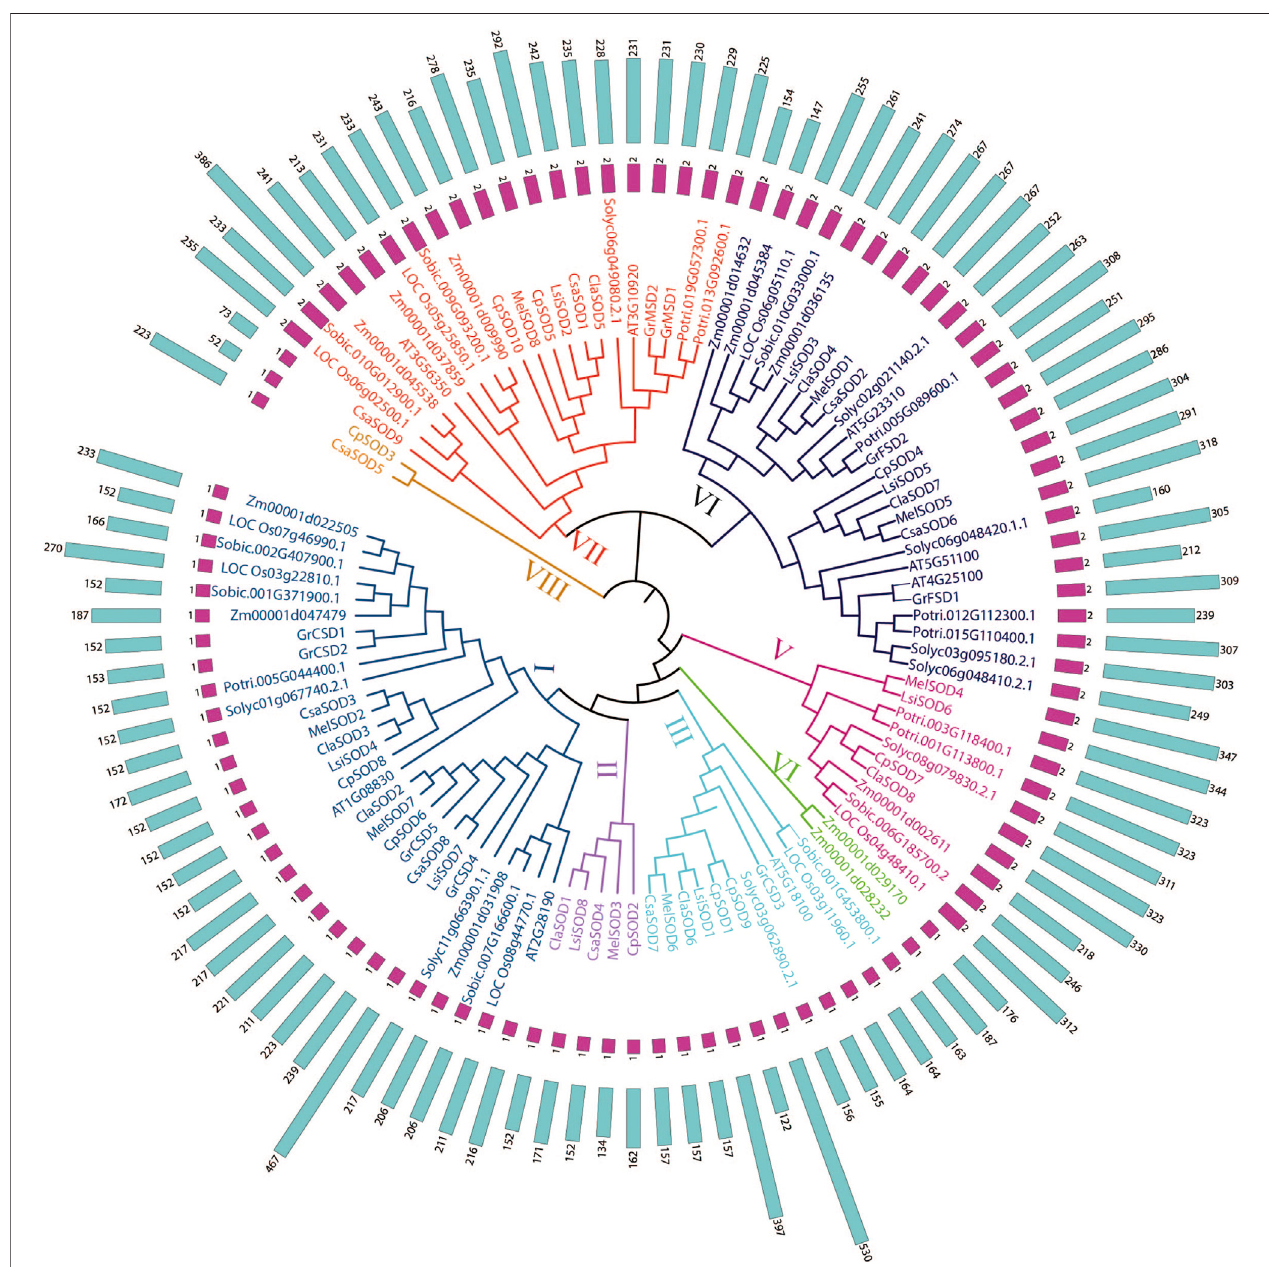
FIGURE1| Phylogenetic treeof106SODproteins from Lagenariasiceraria andotherplantsincluding13plantspecies — Arabidopsis thaliana , Lagenariasiceraria , Citrullus lanatus , Cucurbita pepo , Cucumis sativa , Cucumis melo , Gossypium arboretum , Solanum lycopersicum , Zea mays , Solanum tuberosum , Sorghum bicolor , Populus trichocarpa , and Oryza sativa . Protein sequences were aligned using ClustalW2 sequence alignment program and the phylogenetic tree was constructed by software MEGA7.